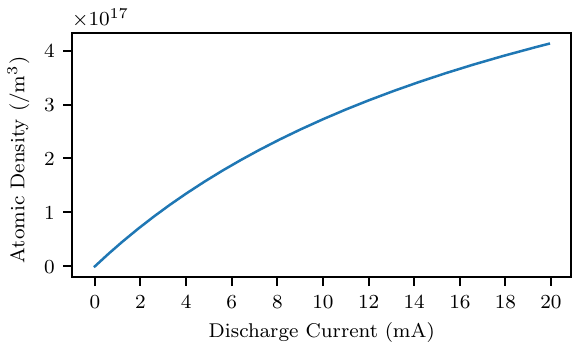
Figure 7. The atomic density in the rubidium HCL versus the discharge current calculated using Equation